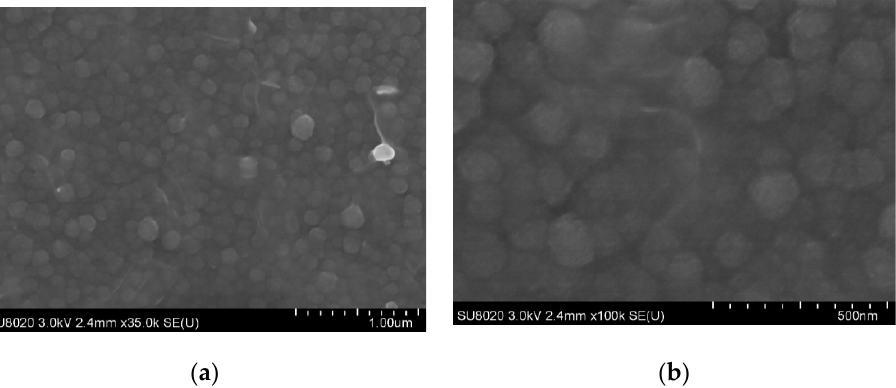
Figure 5. SEM images of a polypyrrole MIP sample taken after the extraction step ( a ) magnification 35,000 times; ( b ) magnification 100,000 times.